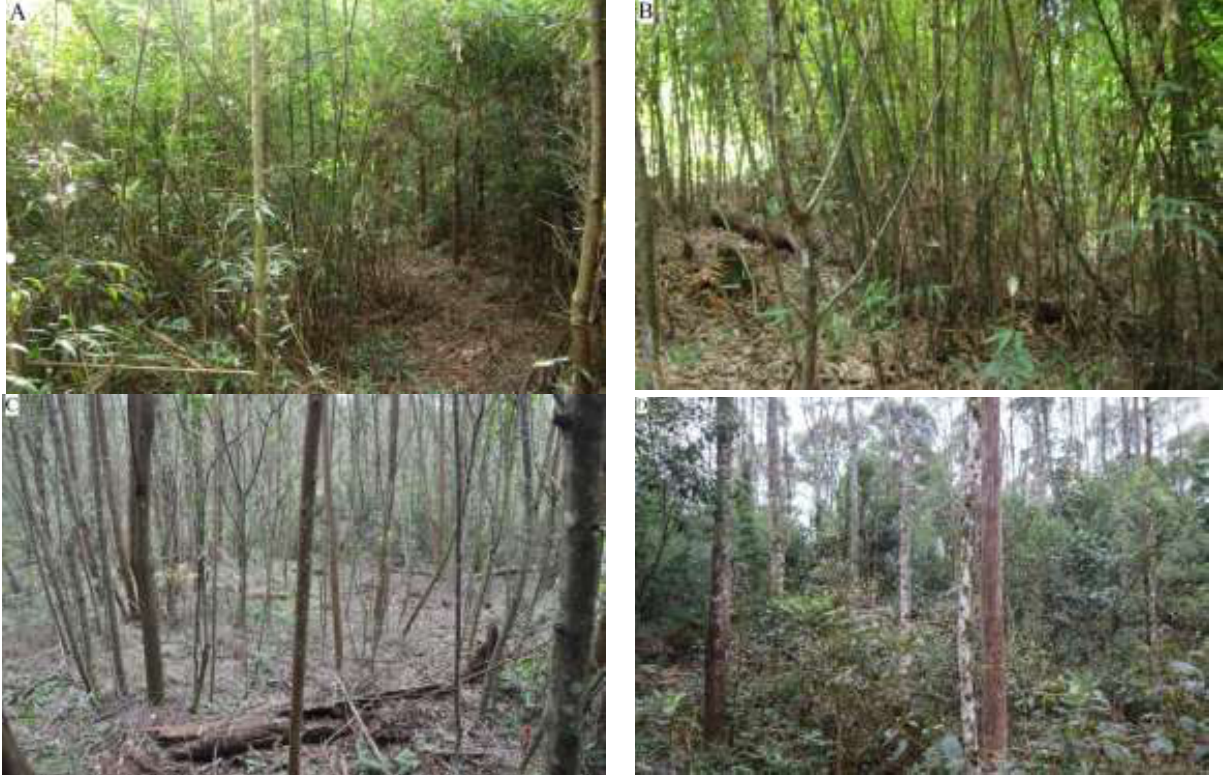
Figure 2. Overview of the understory in a control plot in 2010 ( A ) and 2020 ( B ) showing consistent bamboo dominance, and a removal plot in 2010 ( C ) and 2020 ( D ) depicting successional development in the absence of bamboos.